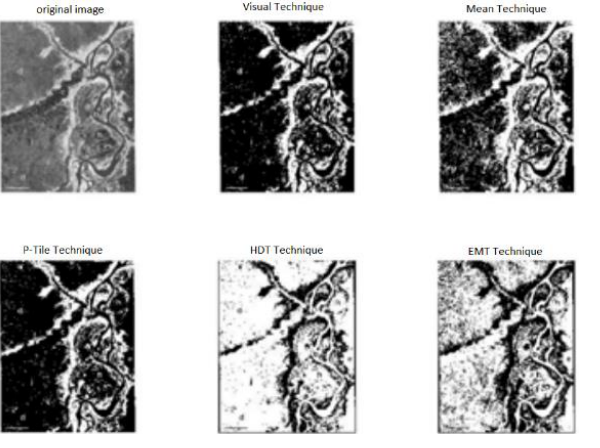
Fig. 11. Threshold techniques [6]